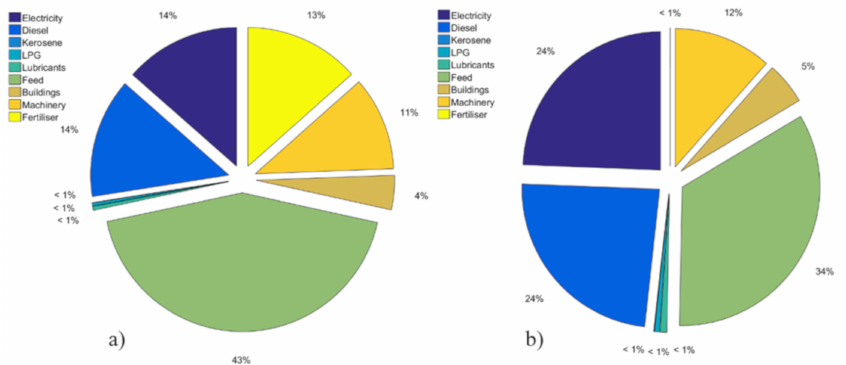
Figure 1. Pie charts showing the breakdown of total primary energy consumption on: a) conventional dairy farm systems and b) organic systems